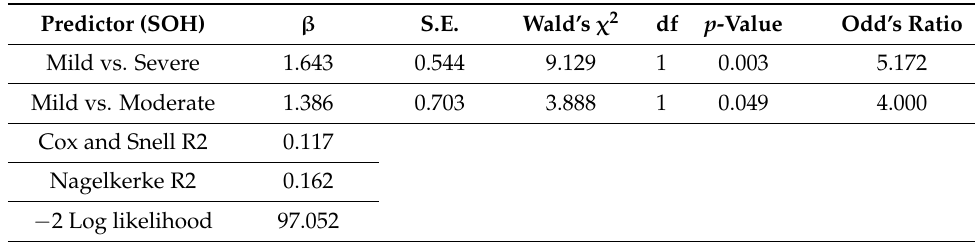
Table 4. Logistic regression of predictor (severity of hyalinization) of recurrence. Predictor (SOH) β S.E. Wald’s χ 2 df p -Value Odd’s Ratio Mild vs. Severe 1.643 0.544 9.129 1 0.003 5.172 Mild vs. Moderate 1.386 0.703 3.888 1 0.049 4.000 Cox and Snell R2 0.117 Nagelkerke R2 0.162 − 2 Log likelihood